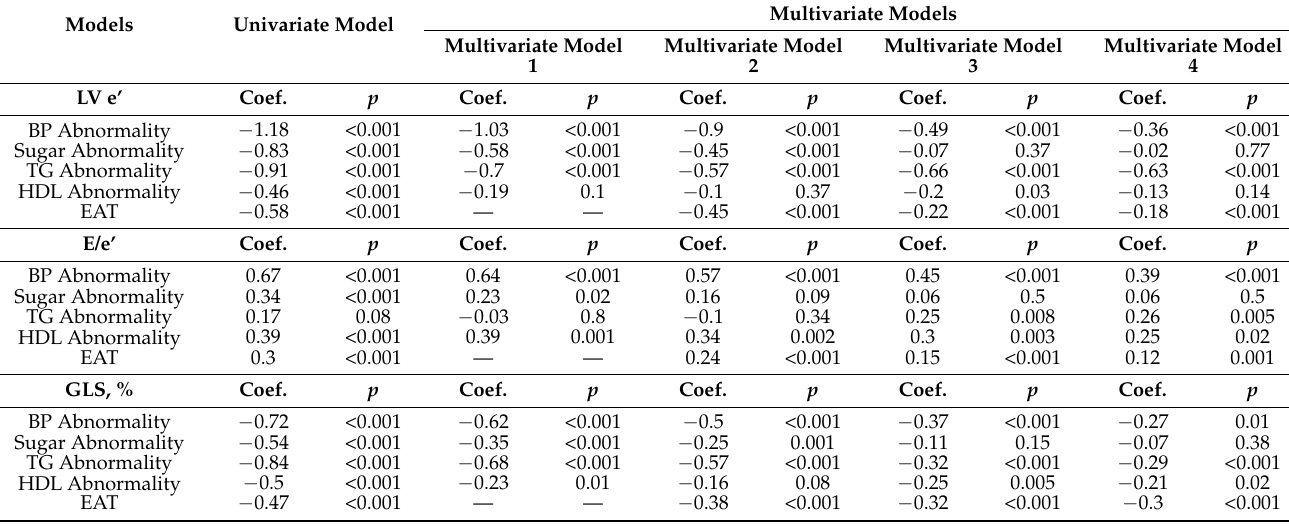
Table 5. Multivariate linear regression analysis on associations of metabolic components or epicardial fat thickness (EAT) with LV diastolic/deformation parameters as dependent variables.